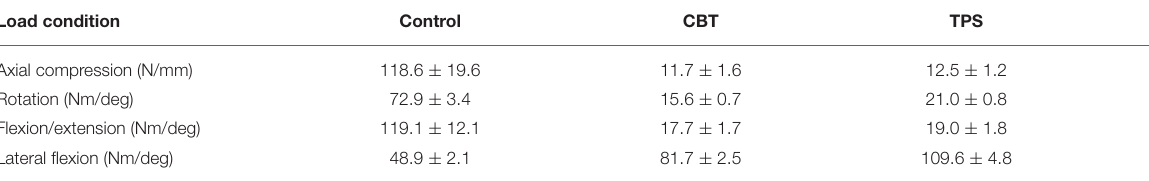
TABLE 2 | The construct stiffnesses under different load conditions.